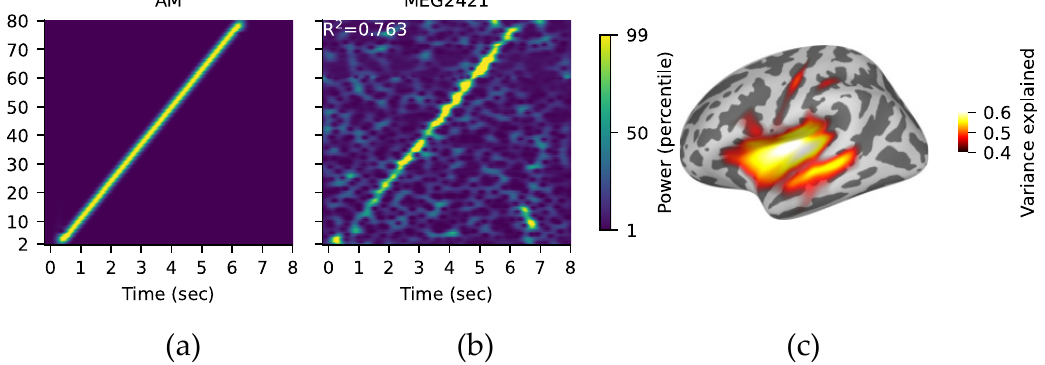
Figure 2. ( a ) TFR map of 2–80 Hz AM white noise. Warm colors indicate increase of oscillatory power. ( b ) TFR map of an example subject + sensor (MEG2421; a right temporal sensor). ( c ) Surface map for GA 3–5 Hz band correlation confirming maximal locking of the AM stimulus in the auditory cortices.